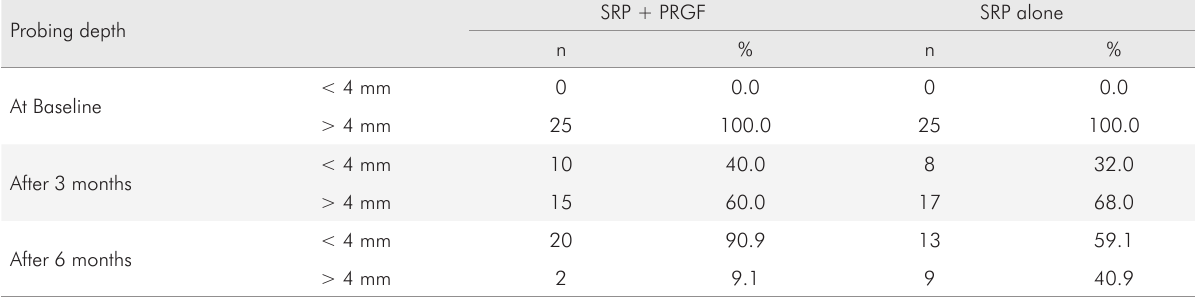
Table 3. Distribution of sites as per probing depths at baseline and after treatment. Probing